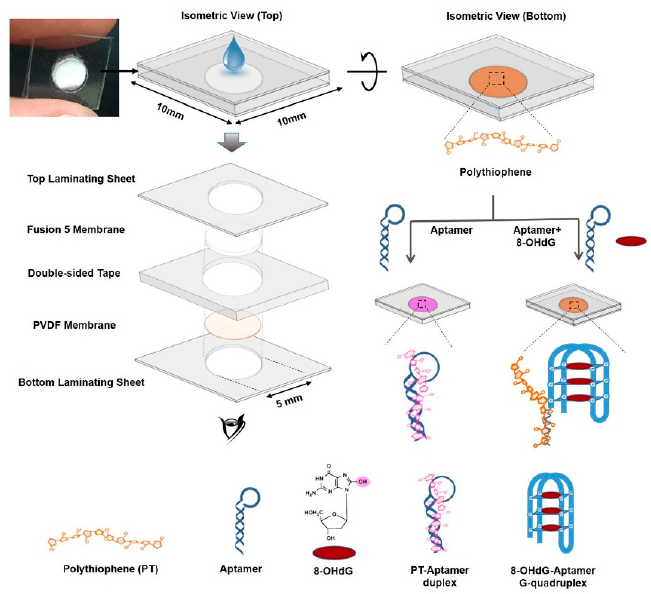
Figure 10. A luminescent paper-based device for the visual detection of o 8 dGuo. Reprinted with permission from Reference [39]. © 2018, American Chemical Society.